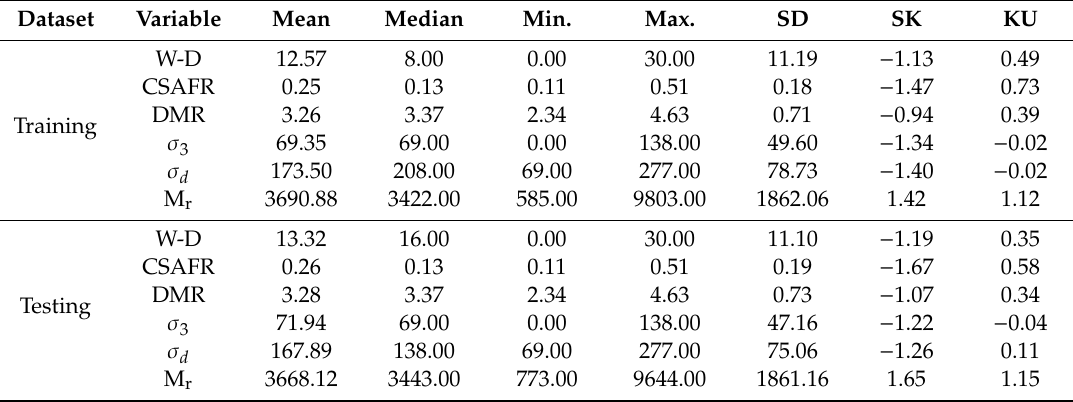
Table 1. Statistical evaluation of training and testing